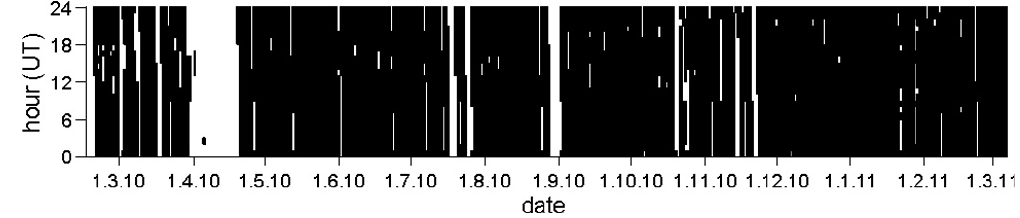
Fig. 2. Times during which the radar data were of sufficient quality to generate a horizontal wind vector. Data are plotted as date and hour of day, missing data are white.